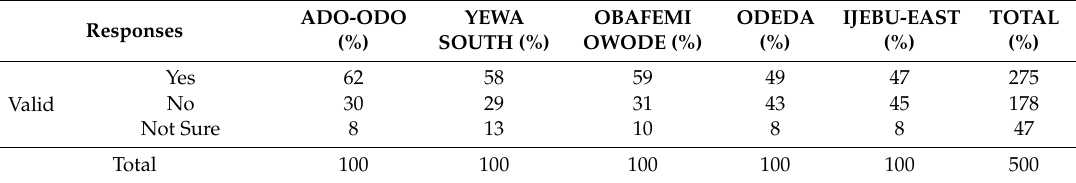
Table 13. Responses on the presence of environmental task forces.